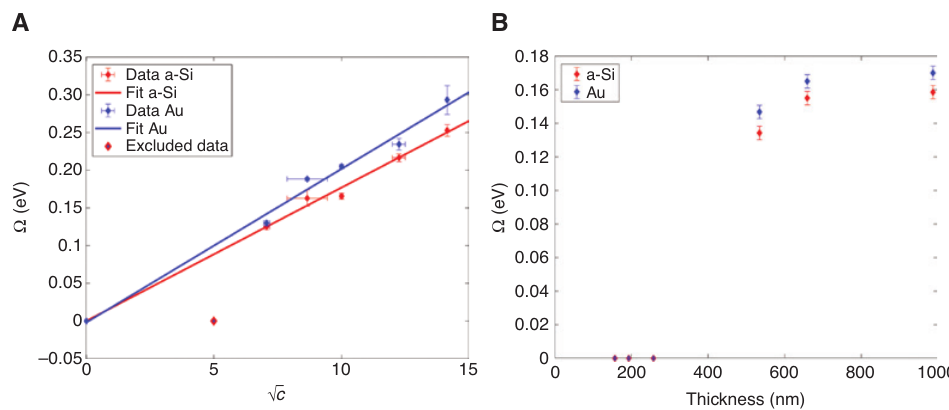
Figure 3: Dependence of the Rabi splitting on the square root of the concentration c for a film thickness of 150 nm (A) and Rabi splitting for c = 25 mm as a function of different film thicknesses